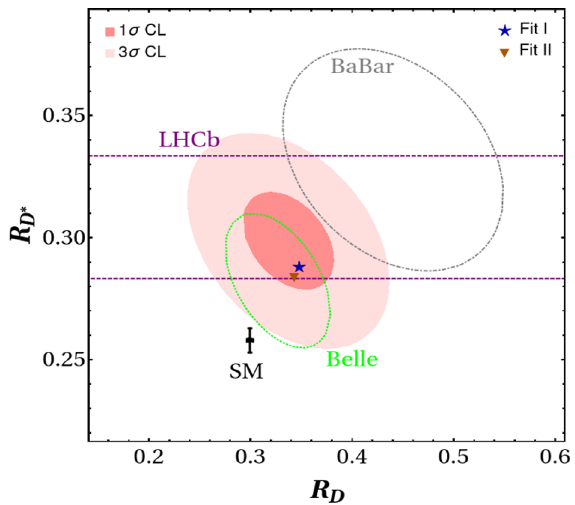
Figure 10 . 1 σ (dark red) and 3 σ (light red) contours for experimental averages from ref. [170] for the LFUV observables R D and R D ∗ observables. Individual 1 σ regions from Belle, BarBar, and LHCb are respectively shown by the dotted green, gray, and purple contours. Black error bar represent the SM prediction, whereas black and brown marker corresponds to the two model Fit I and Fit II given by eq. (7.3) and eq.